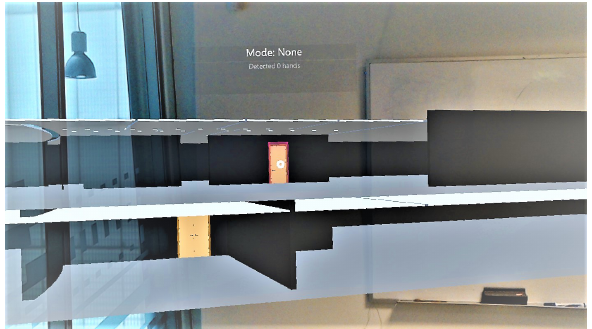
Figure 2. Zooming to the desired key-object.